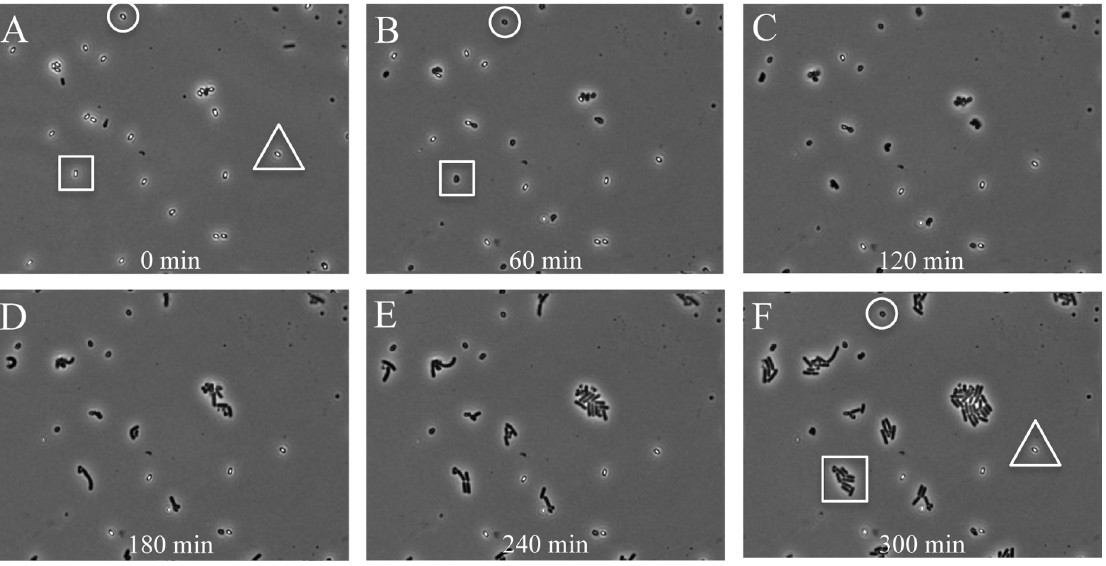
Figure 4. Time-resolved images showing heterogeneous germination and outgrowth of B. subtilis 1A700 spores on minimal medium. Heat-activated spores (70 u C for 30 min) were spotted on 100% defined minimal (MOPS-buffered) medium including AGFK and followed in time using phase-contrast microscopy. The spore marked in the square (Panel A ) becomes phase-dark (germinates) within 60 min (Panel B ), grows out, and forms a microcolony (Panel F ). The spore marked in the circle (Panel A ) becomes phase-dark (Panel B ) but does not grow out within 5 hours (Panel F ). The spore marked in the triangle (Panel A ) remains phase-bright throughout the experiment (Panel F ).